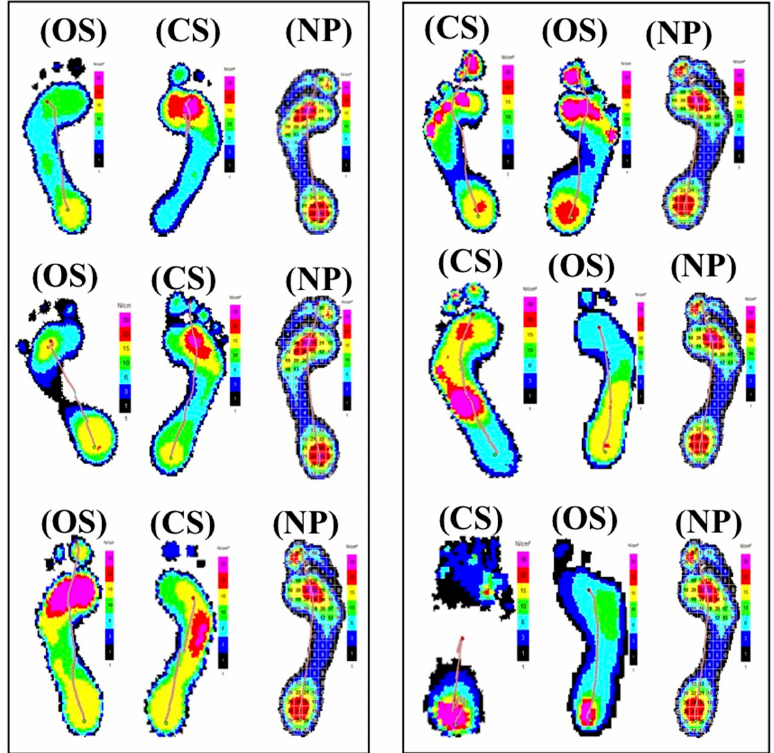
Figure 1. Comparison of maximal pressure images with dynamic foot pressure measurements; (OS): operated side; (CS): contrary side; (NP): normal person.